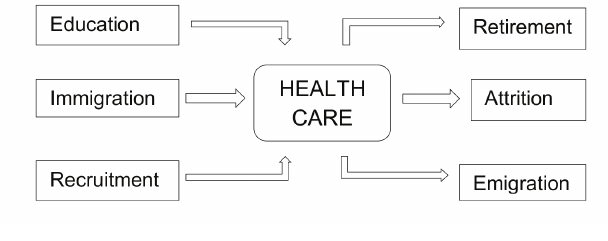
Figure 1 - Stock-flow consistent